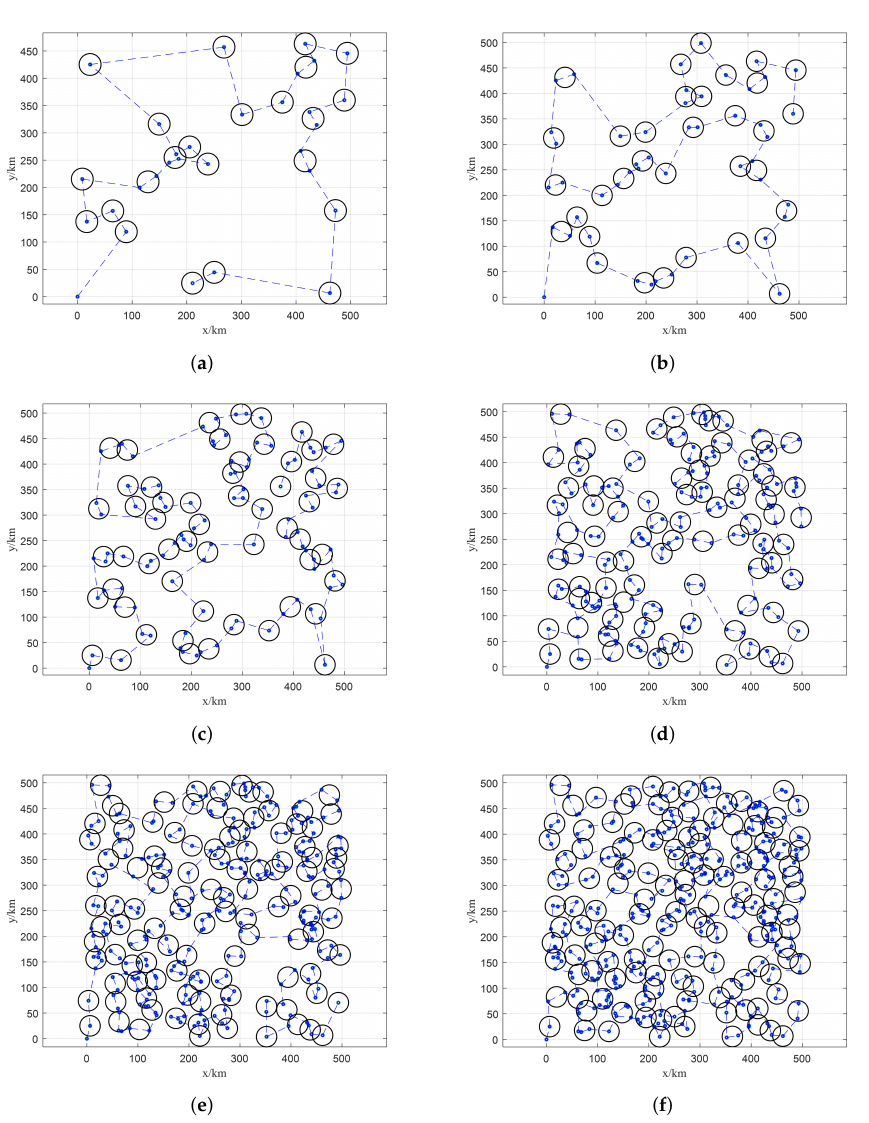
Figure 7. Scheduling results of HATC with different numbers of targets. ( a ) 30 targets, ( b ) 50 targets, ( c ) 100 targets, ( d ) 200 targets, ( e ) 300 targets, ( f ) 400